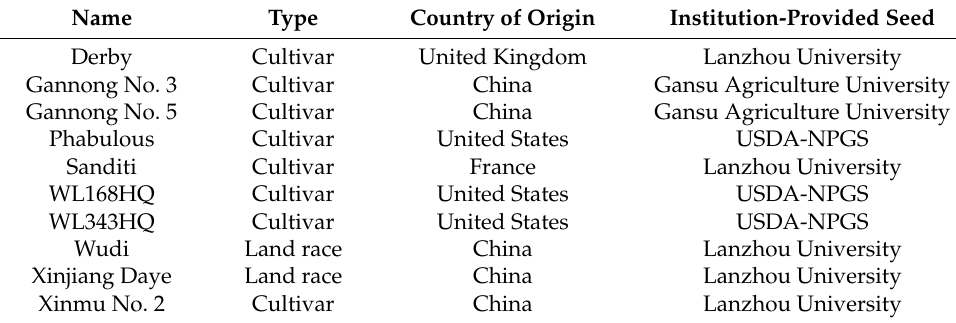
Table 3. Details of 10 alfalfa varieties used in this study.